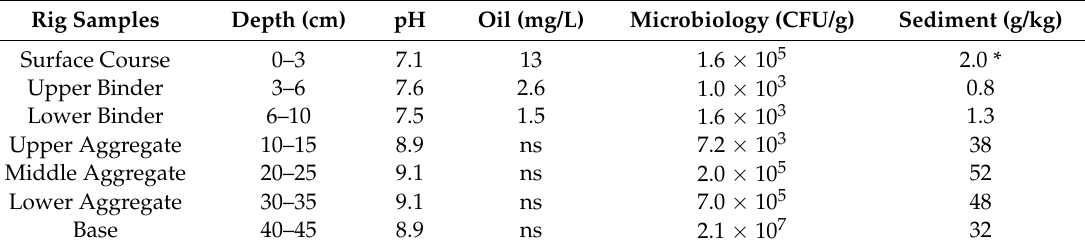
Table 2. Summary of the results from tests from coring